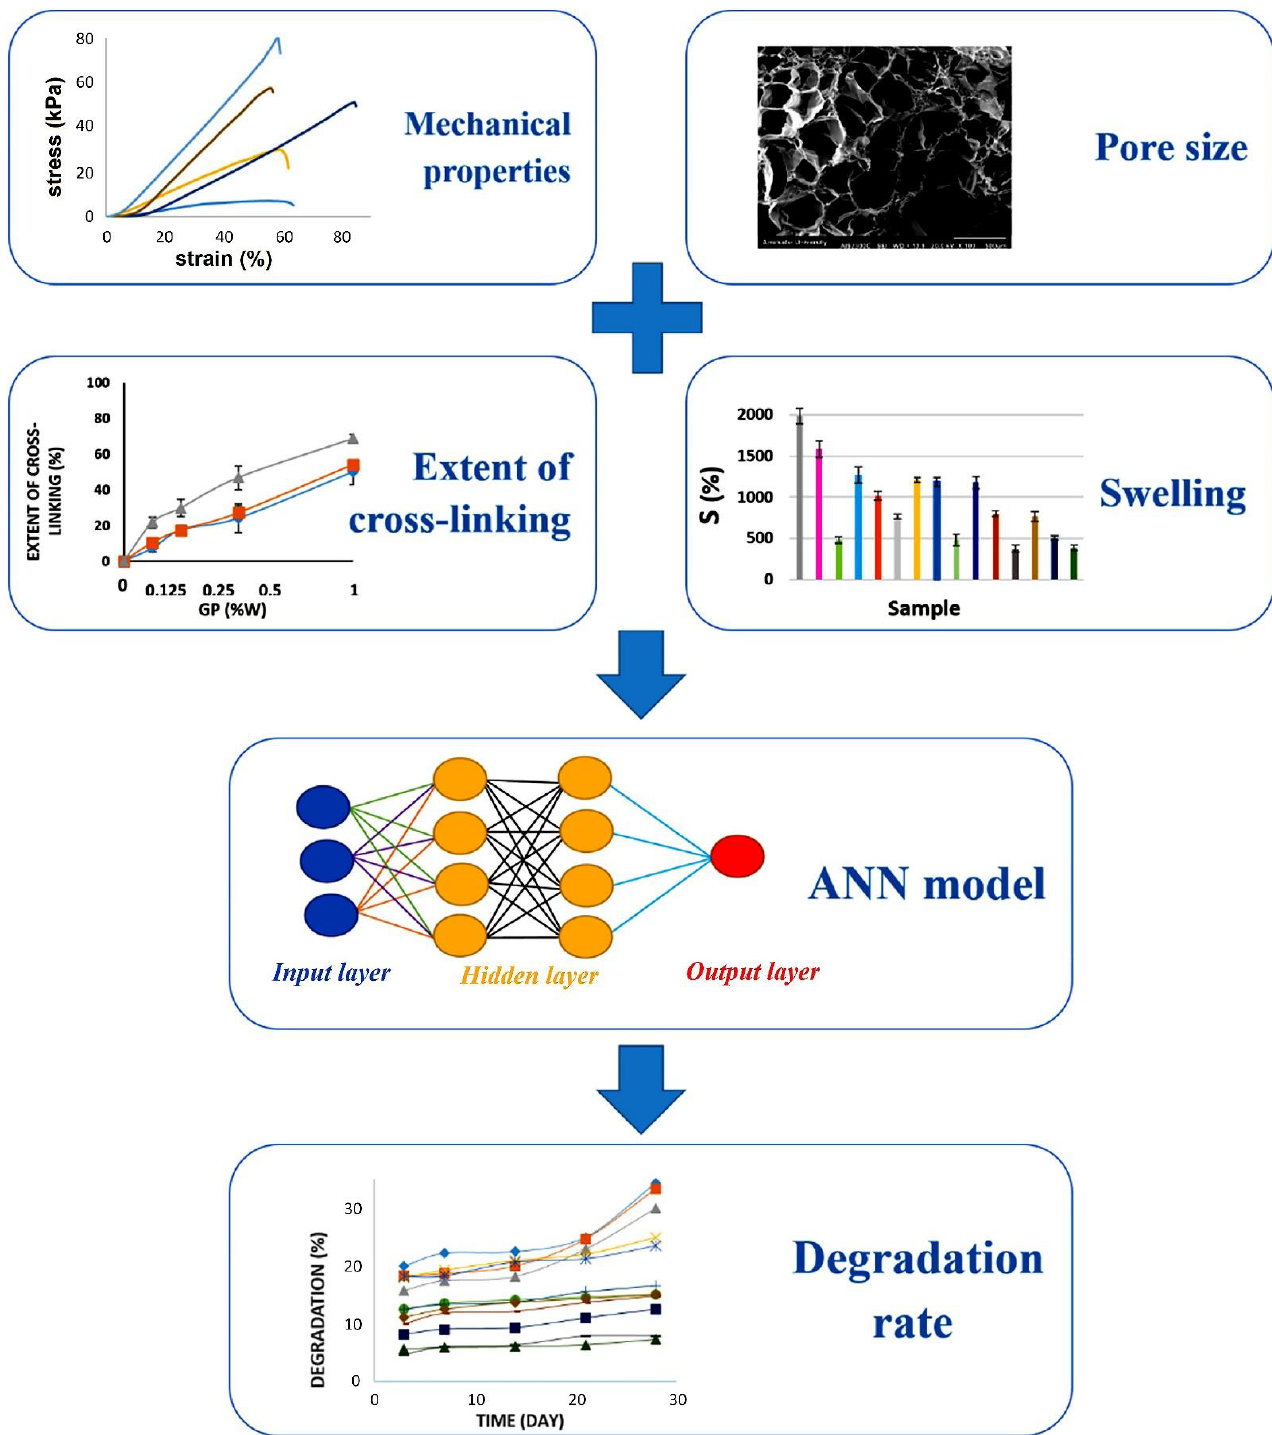
Figure 8. Schematic diagram of the input data (from the material characterisation results) and the output prediction using ML methods. Reprinted with permission from Ref. [18]. 2020, Elsevier.